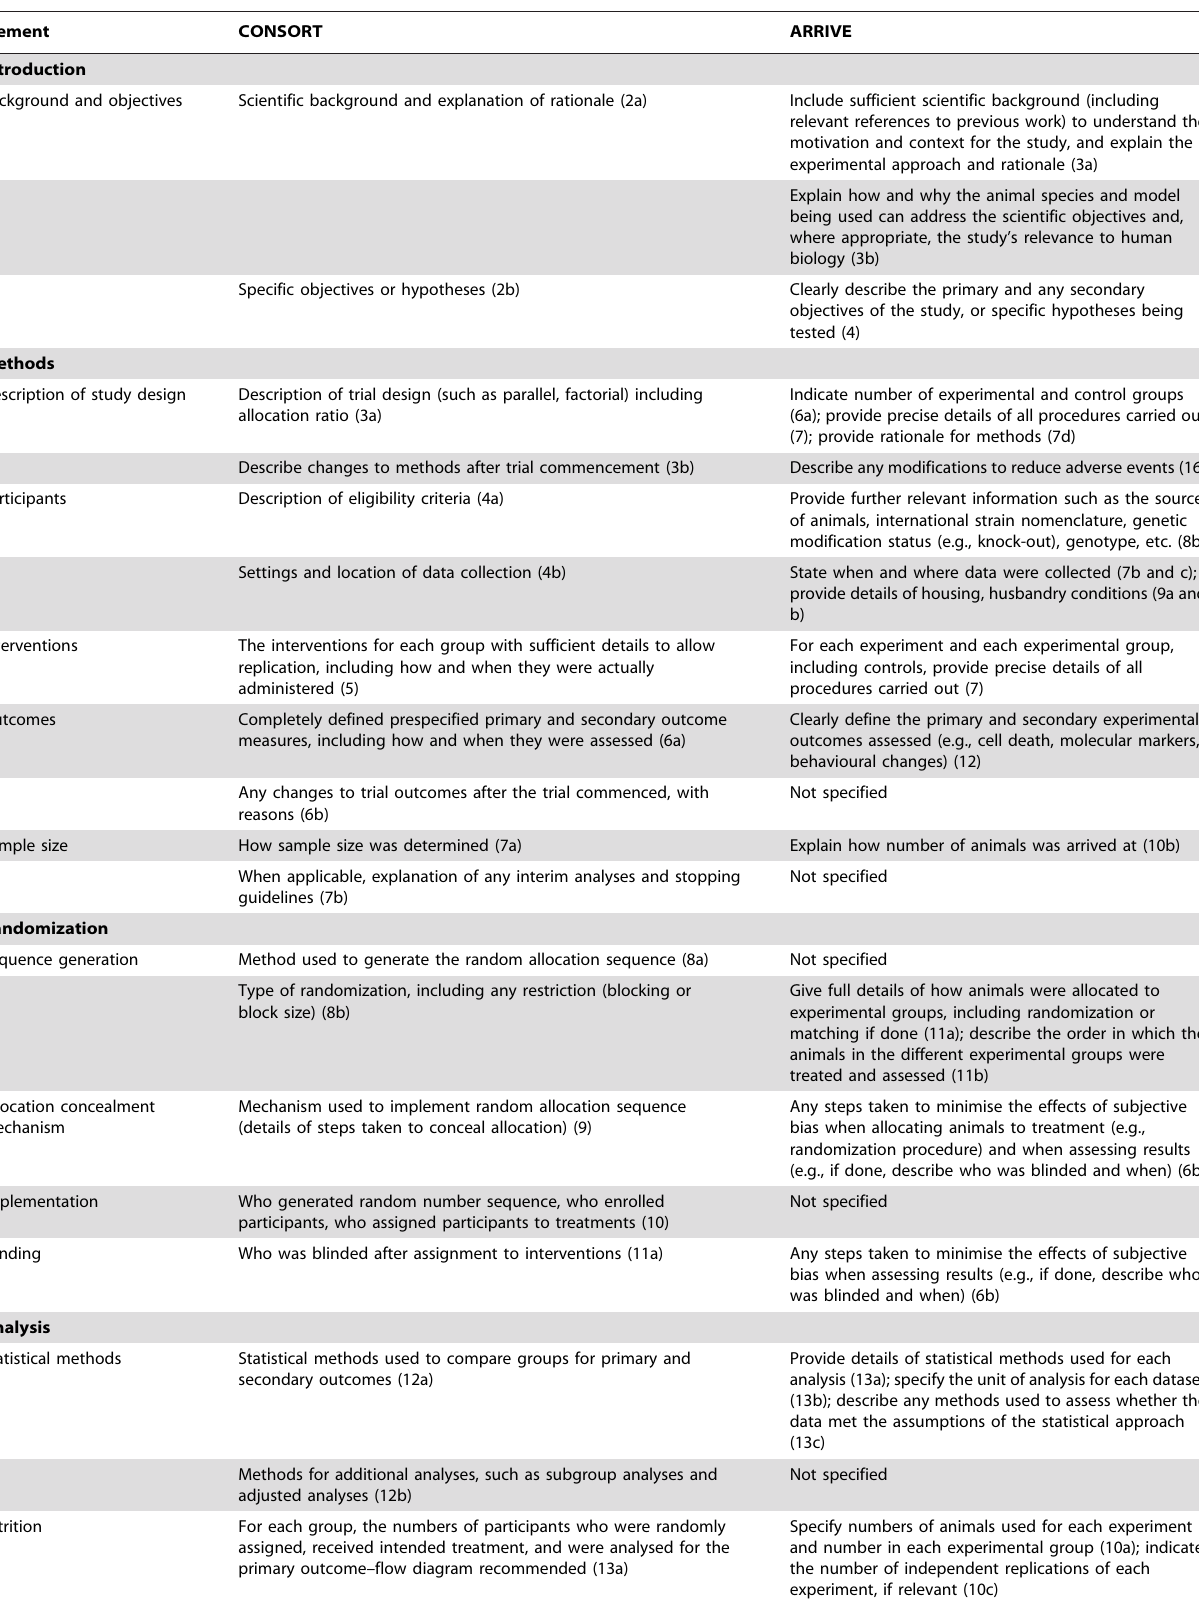
Table 1. Comparison of the CONSORT and ARRIVE guidelines.